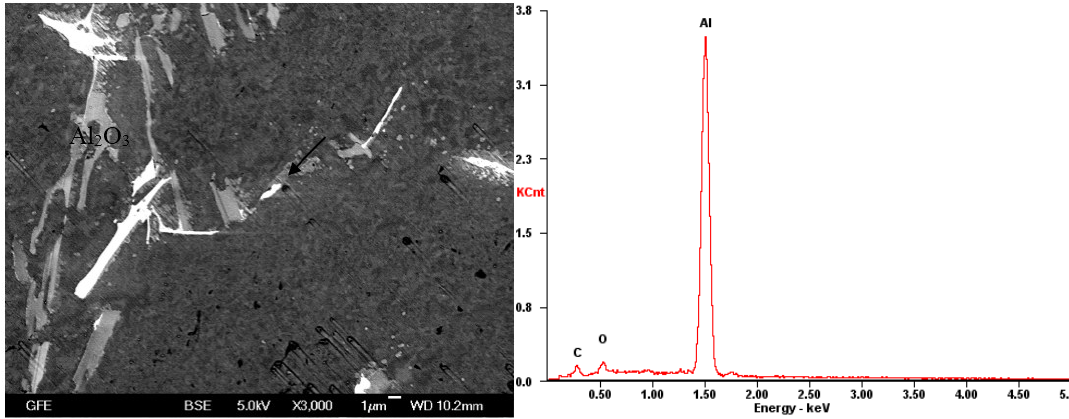
Figure 11. The SEM ( left ) and EDX ( right ) for the Al-Al 2 O 3 nano-reinforced